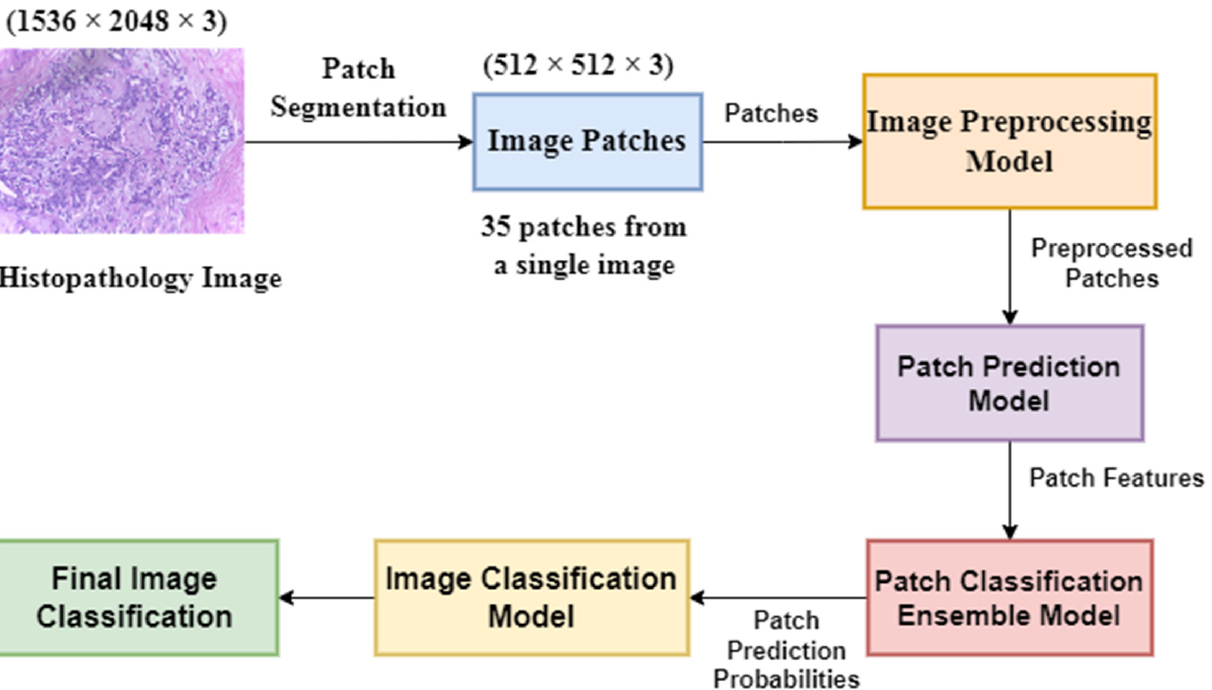
Figure 1. The overall pipeline of the proposed method.